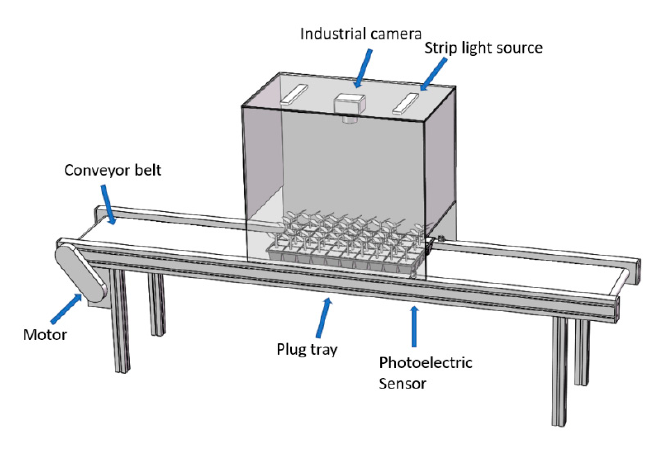
Figure 1. Main components of the classification system.